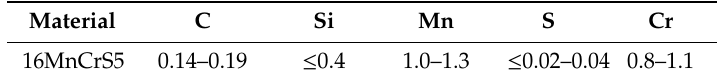
Table 1. Chemical composition of the investigated low-alloyed case hardening steel 16MnCrS5, in wt %